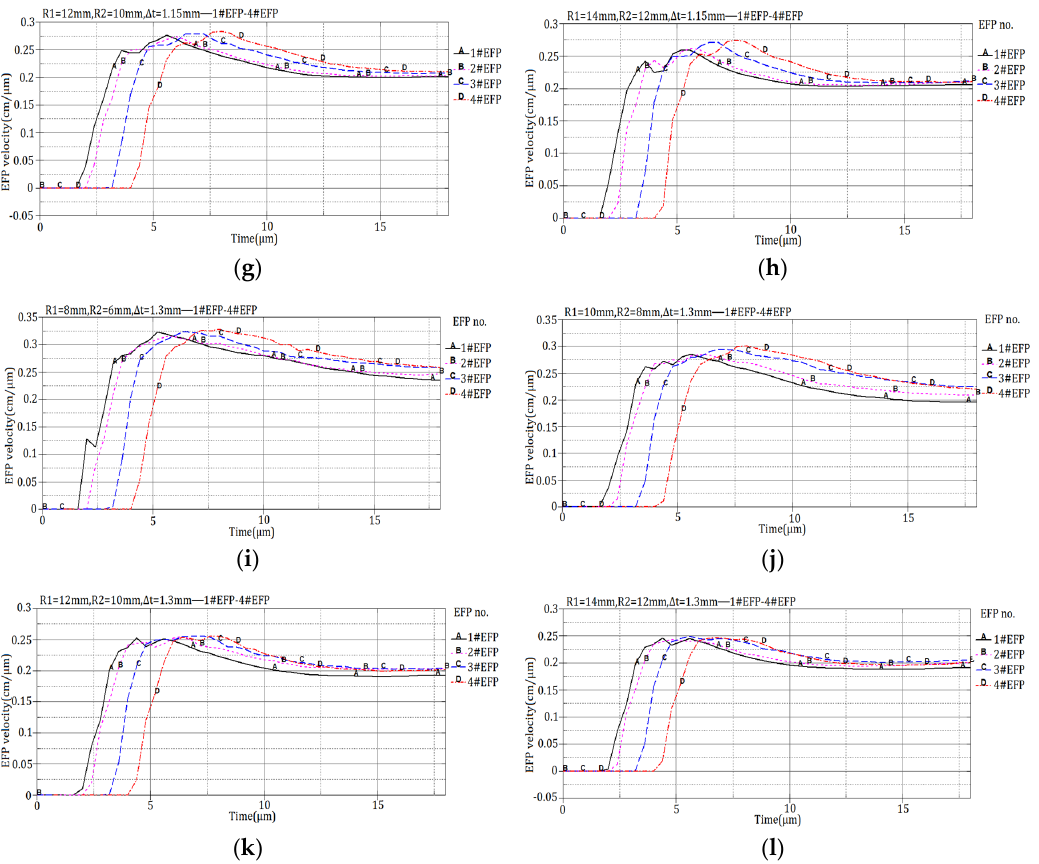
Figure 5. Projectile forming velocity of integral circumferential MEFP warhead: ( a ) Scheme 1 forming velocity; ( b ) Scheme 2 forming velocity; ( c ) Scheme 3 forming velocity; ( d ) Scheme 4 forming velocity; ( e ) Scheme 5 forming velocity; ( f ) Scheme 6 forming velocity; ( g ) Scheme 7 forming velocity; ( h ) Scheme 8 forming velocity; ( i ) Scheme 9 forming velocity; (j) Scheme 10 forming velocity; ( k ) Scheme 11 forming velocity; ( l ) Scheme 12 forming velocity.